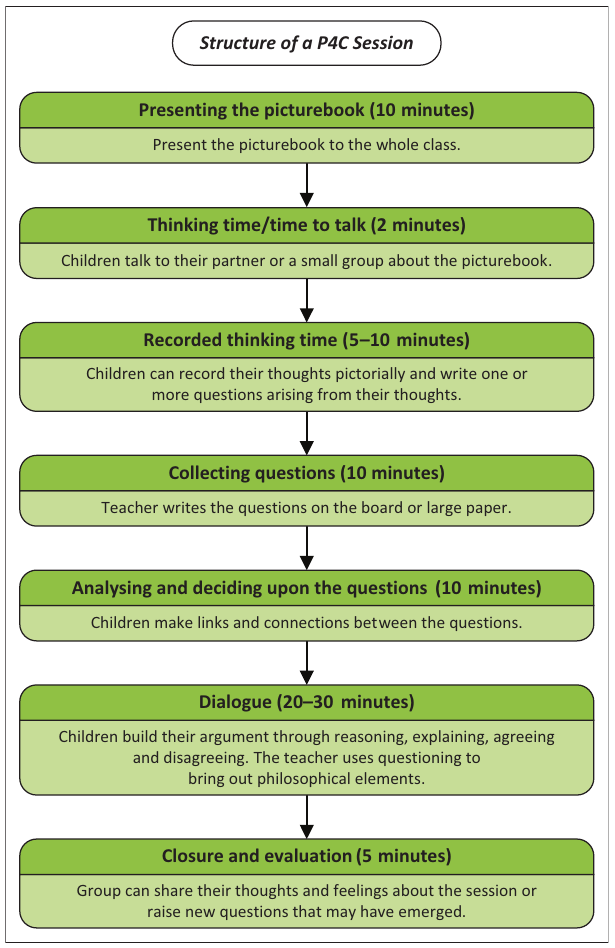
FIGURE 1: Structure of a philosophy with children (P4C)